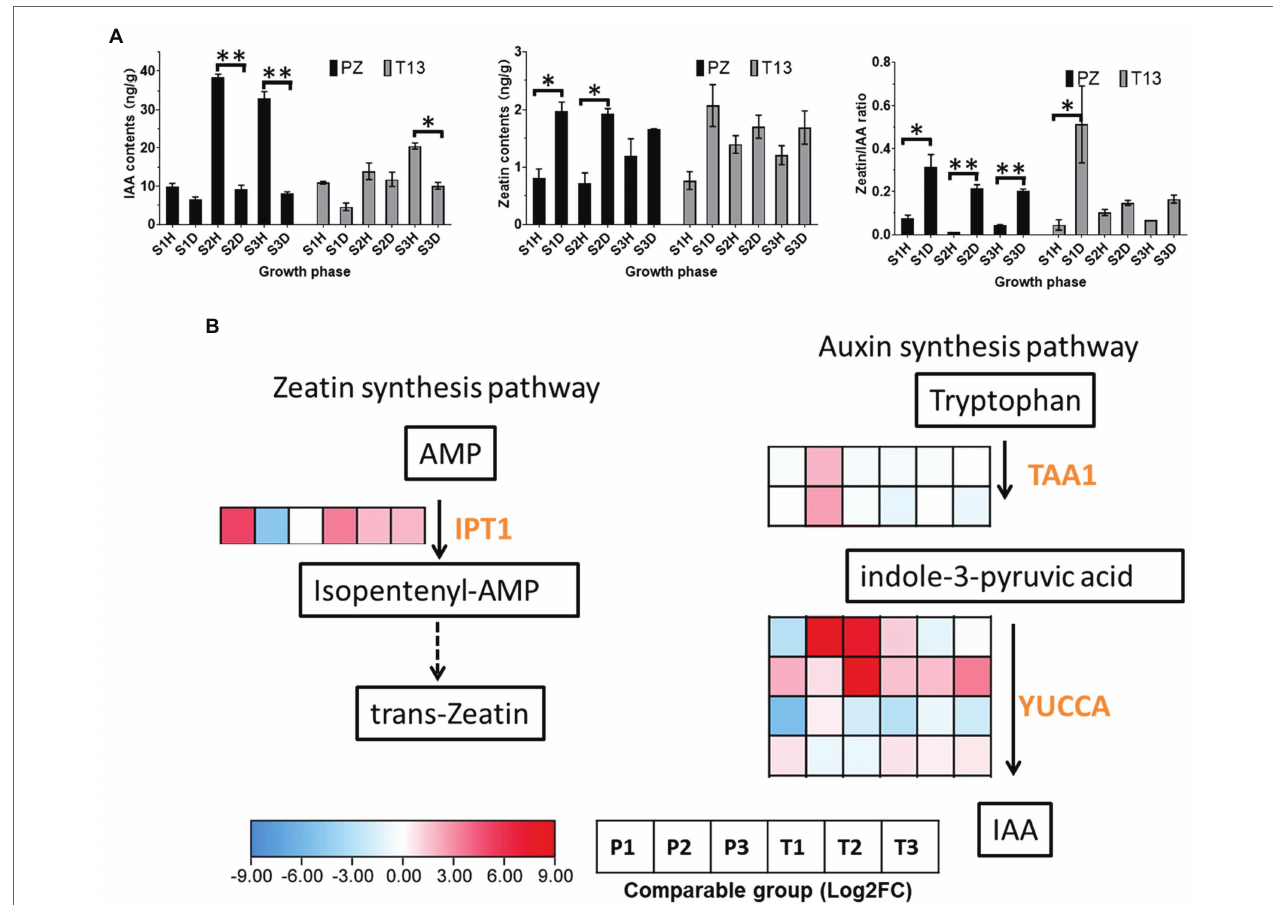
FIGURE 7 | Auxin and cytokinin changes and heatmap of DEGs involved in their synthesis pathway in “PZ” and “T13” leaves infected by phytoplasma. (A) IAA and zeatin contents and the ratio of zeatin to IAA changes in three growth phases in healthy and diseased “PZ” and “T13” with three biological replications. Error bar represents SE ( n = 3). (B) Heatmap of the expression level of key genes involved in IAA and the zeatin synthesis pathway with Log2FC calculation. P1 and T1 represent the Log2(disease/healthy) results at growth phase S1 in “PZ” and “T13,” respectively. P2 and P3 and T2 and T3 have the corresponding meanings, as well as P1 and T1, respectively. IPT, isopentenyl transferase; TAA, tryptophan amino transferase; and YUCCA, flavin monooxygenase gene. * p < 0.05; and ** p <